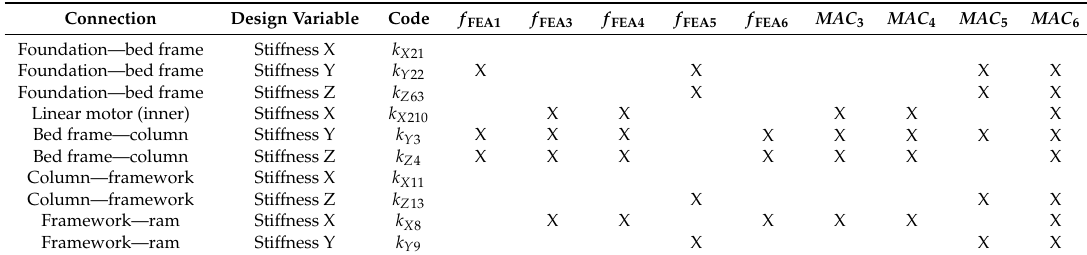
Table 6. Summary of variables affecting responses.